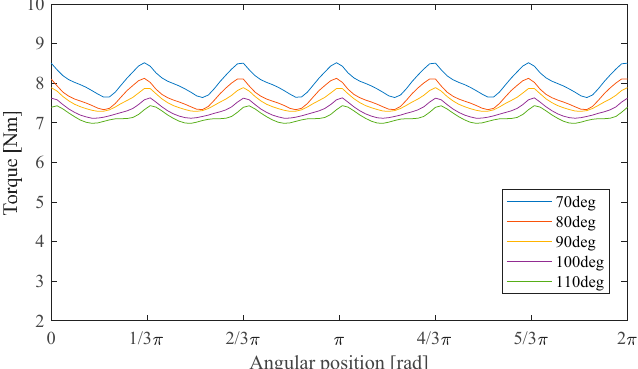
/ min for each rms , 6000 r